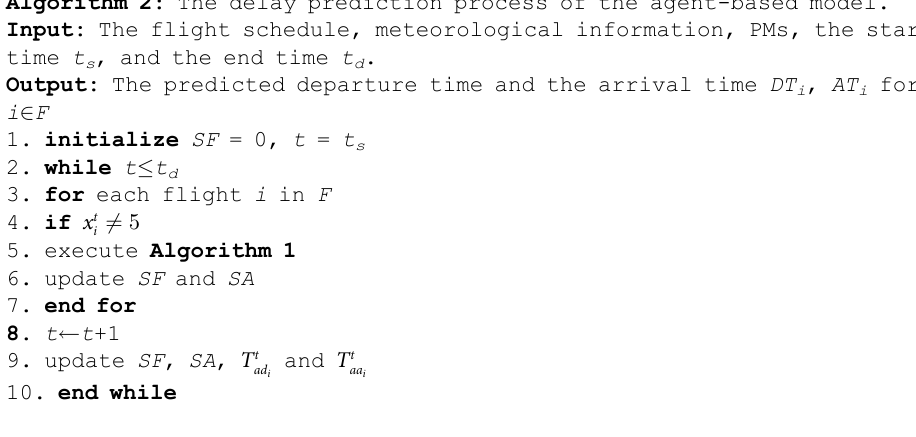
Algorithm 2 : The delay prediction process of the agent-based